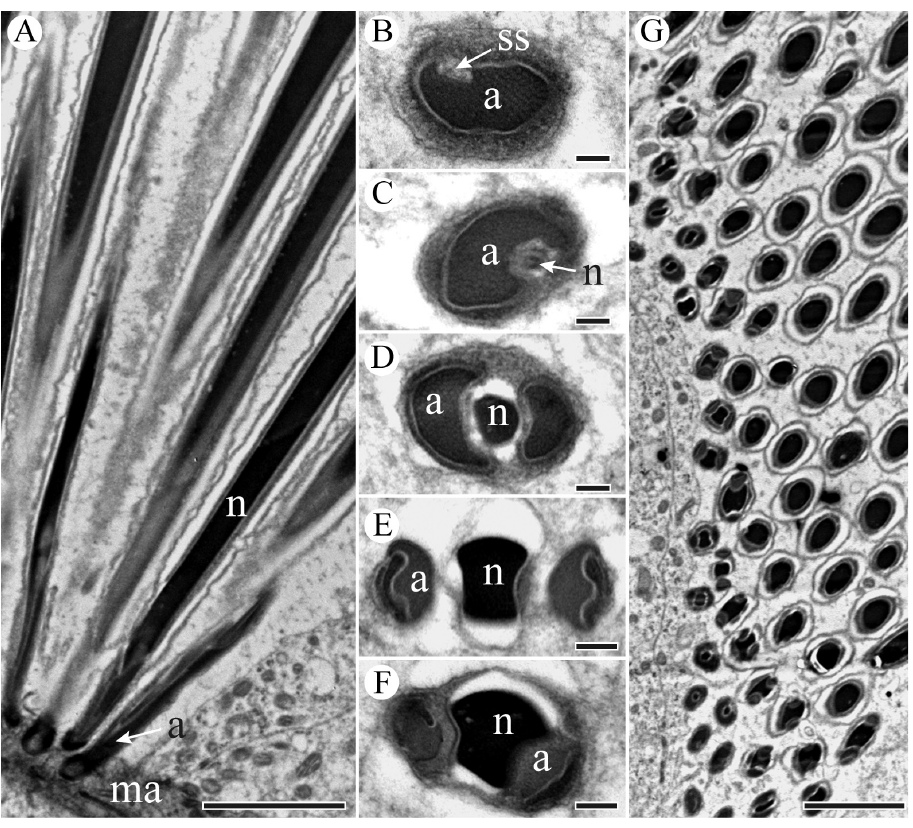
Figure 5. TEM micrographs of sperm head region of K. caelatata. A Longitudinal section of head region, showing the head region (including acrosome (a) and nucleus (n)) inserted into a homogenous matrix (ma) B Cross-section through the acrosome (a), showing the subacrosomal space (ss) located at an eccentric posi- tion of acrosome C Cross-section through the acrosome, showing the nucleus (n) located at an eccentric position of acrosome D–F Cross-sections through the posterior region of the acrosome (a), showing two acrosomal processes and the nucleus (n) G Lower magnification of cross-section through spermatodesmata, showing different transverse sections of spermatozoa. Scale bars: 2 μm ( A, G ), 100 nm ( B–F